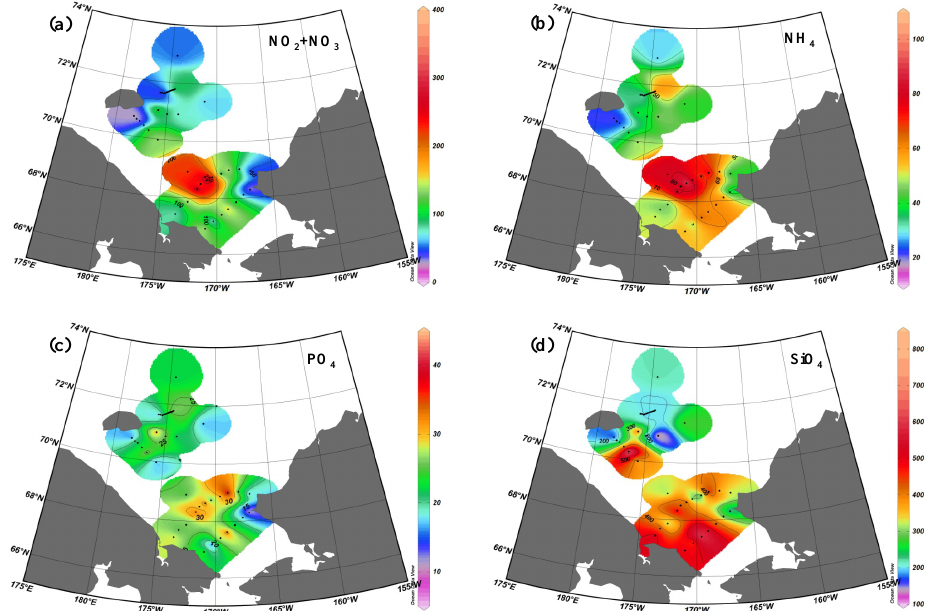
Figure 3. The distributions of the integrated concentrations of ambient nitrite + nitrate [NO 2 + NO 3 ] (mmolm − 2 ) (a) , ammonium [NH 4 ] (mmolm − 2 ) (b) , phosphate [PO 4 ] (mmolm − 2 ) (c) , and silicate [SiO 4 ] (mmolm − 2 ) (d) from the surface to 30m during the 2012 RUSALCA expedition.